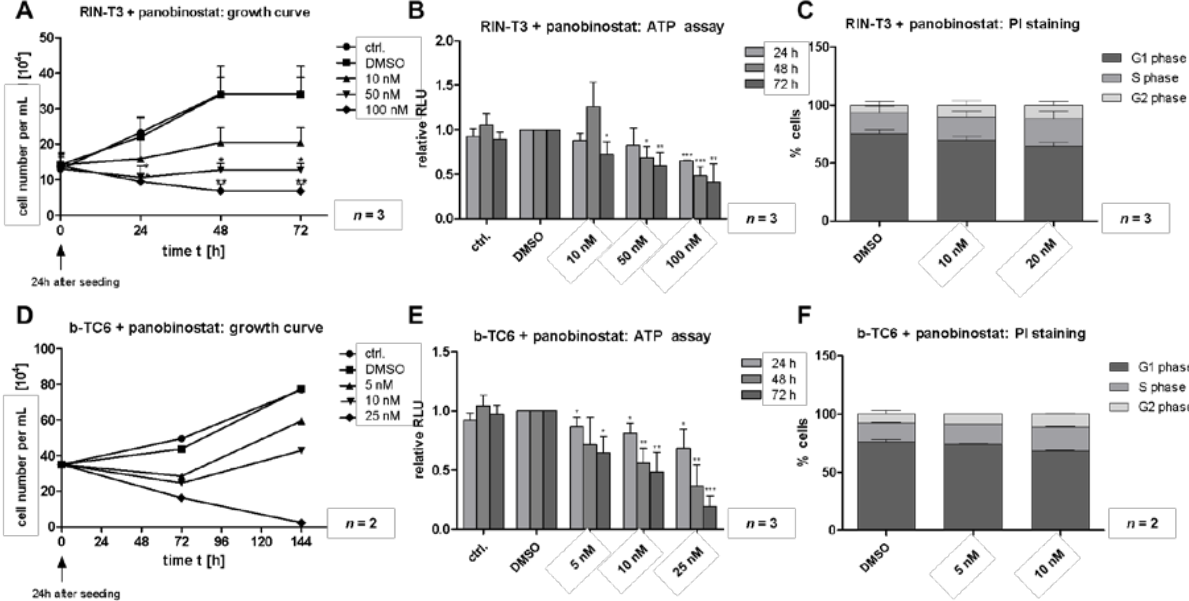
Figure 1. Panobinostat induces a time- and dose-dependent cytotoxic phenotype in murine NET cells. RIN-T3 (rat) and b-TC6 (mouse) cells were treated with increasing concentrations of panobinostat (PB) (5 nM, 10 nM, 20 nM, 25 nM, 50 nM, 100 nM) and analyzed for cell proliferation, viability and cell cycle. ( A ): Cell counting was performed every 24 h showing a significant reduction in proliferation of RIN-T3. ( B ): Cell viability was significantly reduced from a PB concentration of 50 nM (ATP assay). ( C ): PI-mediated analyses of cell cycle regulation showed no significant effect in RIN-T3 cells. ( D ): Cell counting of b-TC6 cells was performed every 24 h up to 144 h and shows a reduction after 72 h by use of 25 nM PB ( n = 2). ( E ): ATP assay revealed significant reduction of b-TC6 cell viability after 24 h of treatment. ( F ): PI-mediated analyses of cell cycle regulation showed no effect of PB in b-TC6 cells ( n = 2). DMSO was for control. Error bars: SD; n = 3; * p < 0.05, ** p < 0.01, *** p < 0.001; according to an unpaired one-sample Student’s t -test.